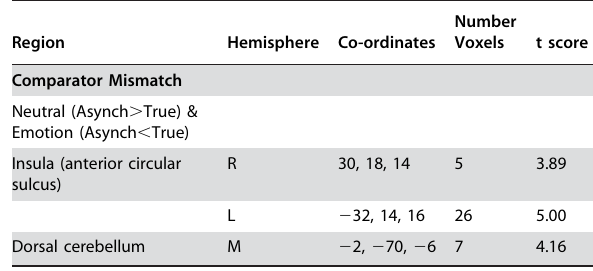
Table 2. Neural activity associated with physiological